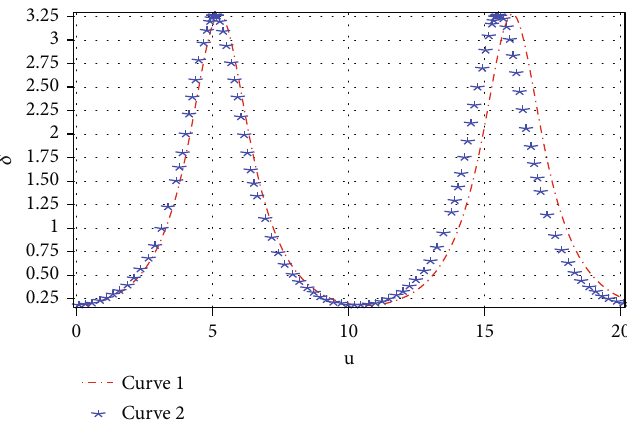
Figure 13: Sensitivity of model for initial conditions ð u , δ Þ = ð 0 : 18,0 : 01 Þ and ð u , δ Þ = ð 0 : 2,0 : 02 Þ with free parameters S = − 1 , T = 2 , V = 1 , κ = 2 , l = 1 , and β = 1 while both conditions represent the curves in red and blue colors, respectively. 1